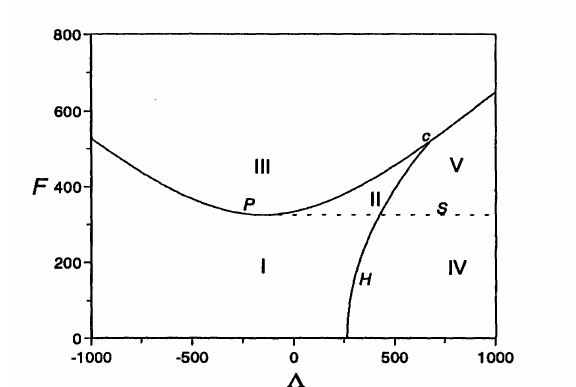
FIGURE 4 Various regions of interest obtained from the linear and nonlinear stability analyses for a simply supported panel, w* = 8.1076, (T = 25/w*, ILl = IL2 = lO/w*, AI2 = -99.2A/w*4,fI2 = 202.5F/w*4, and 0!14 = 5729/w*4. The P and H curves define the linear flutter boundaries. The P curve corresponds to pitchfork bi furcations, the H curve corresponds to Hopf bifurca tions, and the S curve corresponds to saddle-node bi